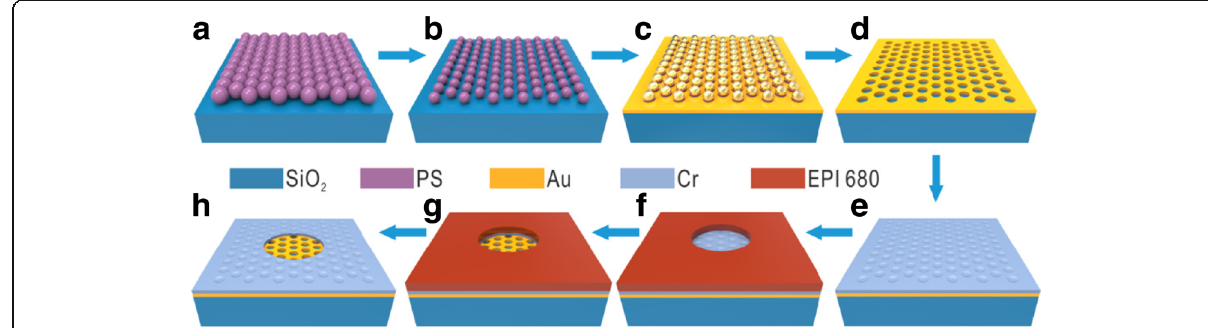
Fig. 1 Schematic of the main process steps for fabricating the microlenses and their arrays. a Spin coating of monolayer PS nanospheres. b size shrinkage of PS nanospheres. c Au deposition. d removal of PS nanospheres. e Cr deposition. f transfer of microlenses patterns onto photoresist. g wet etching. h removal of